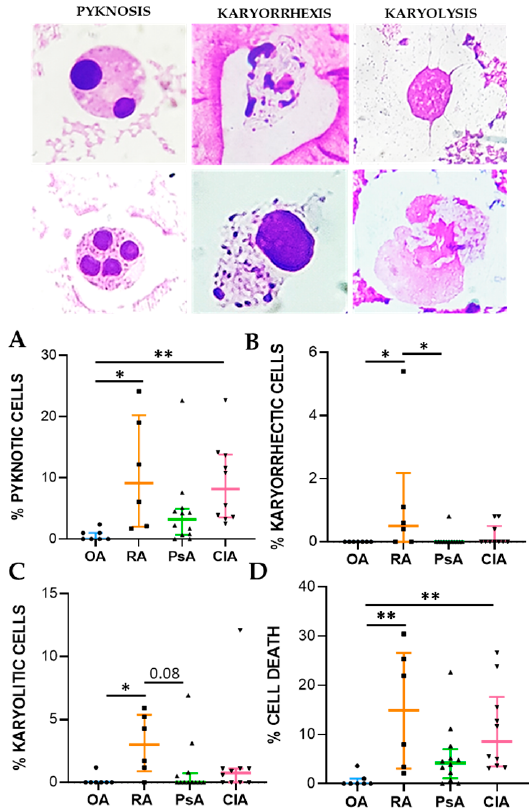
Figure 3. Cell death rates of leukocyte cells in SF from OA (n = 7), RA (n = 6), PsA (n = 12), and CIA patients (n = 10). Upper panel: representative image of pyknotic, karyorrhectic, and karyolitic leukocytes stained with MGG. Lower panel: rate of pyknotic leukocytes ( A ), karyorrhectic leukocytes ( B ), karyolitic leukocytes ( C ), and cell death ( D ). Data are shown as the median (IQR). p calculated according to the Kruskal–Wallis test. Dunn’s post hoc test: * p < 0.05, ** p < 0.01.